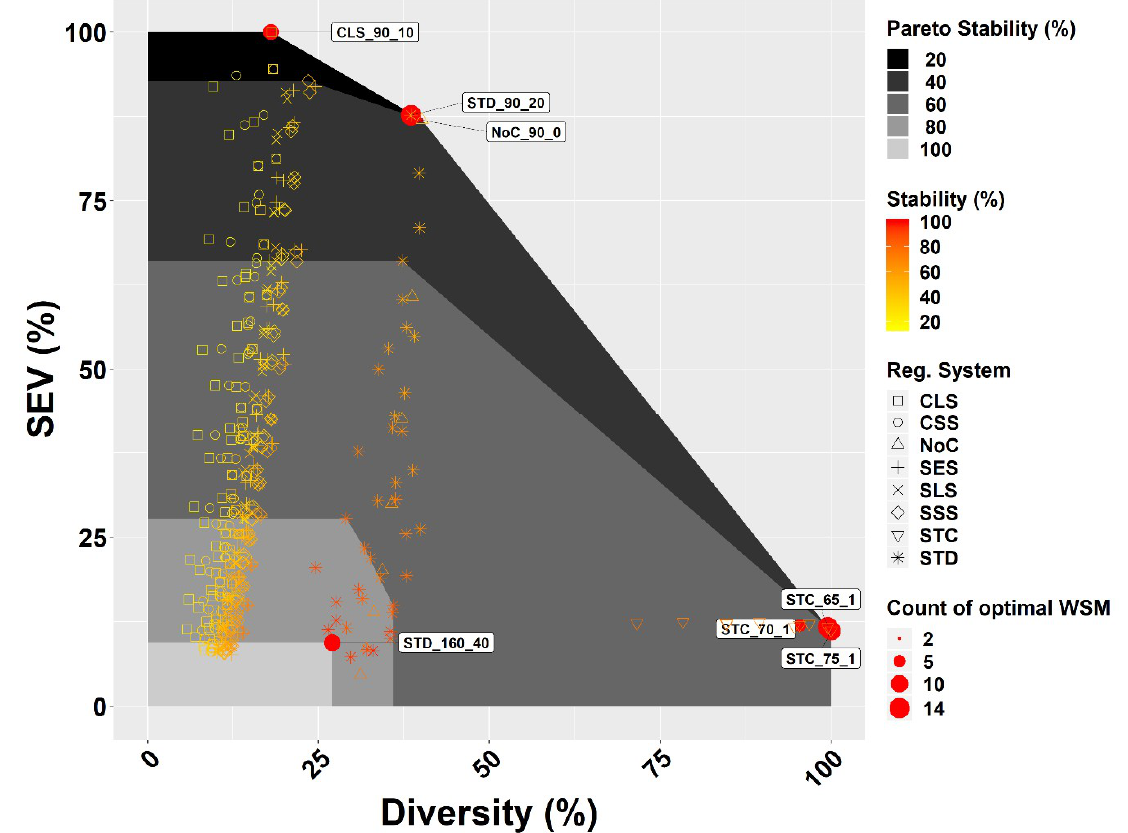
Figure 6. A three‐dimensional graph illustrating relationship between the relative values (%) of all three selected indicators simultaneously. Red dots refer to optimal variants (see Table 3 for an explanation of abbreviations) selected based on the weighted summation method for different combinations of criteria weights. Legend: CLS = large‐scale clearcutting system, CSS = small‐scale clearcutting, NoC = no cutting, SES = shelterwood expanding scale, SLS = shelterwood large scale, SSS = shelterwood small scale, STC = selection single tree cutting system, STD = shelterwood based on target diameter.